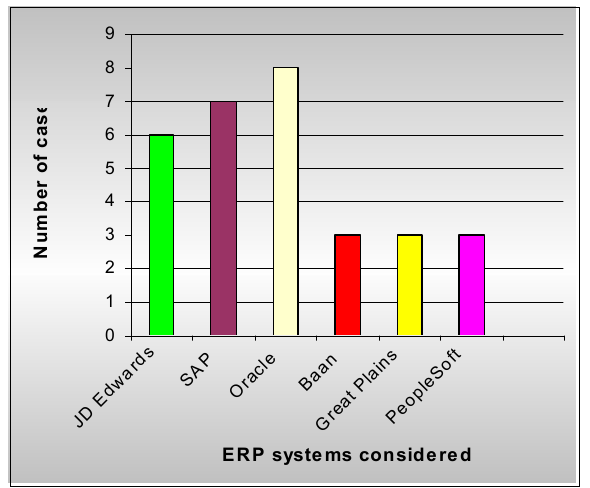
Figure 2: ERP systems considered by